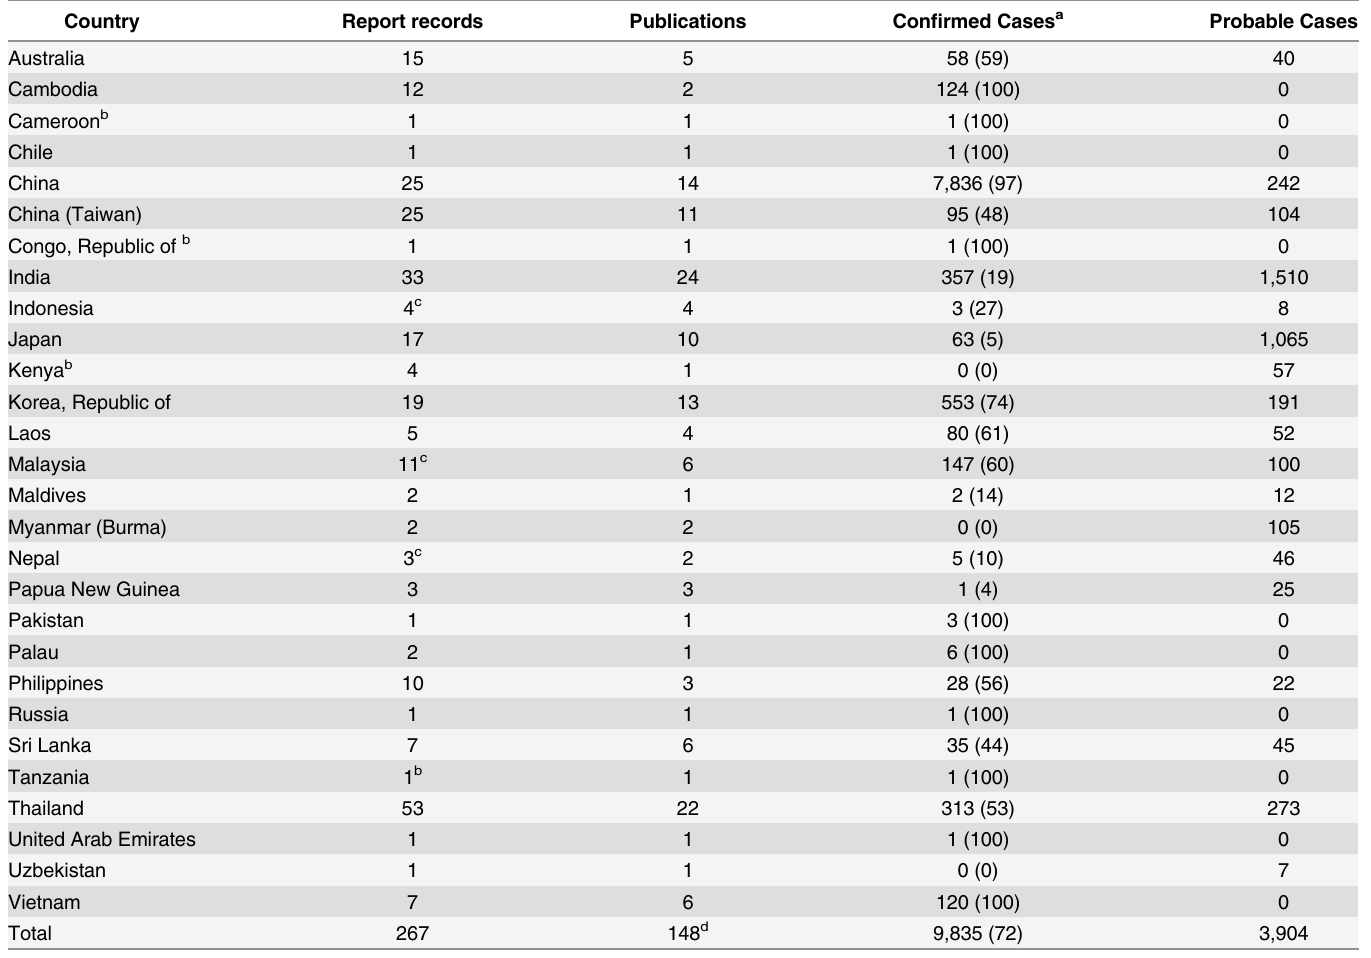
a Brackets show percentage of scrub typhus cases scored as “ con fi rmed. ” b Case con fi rmed or probable but country of acquisition may not be. c Excludes seroepidemiology publications listed in Table 3. d Three publications included two or more